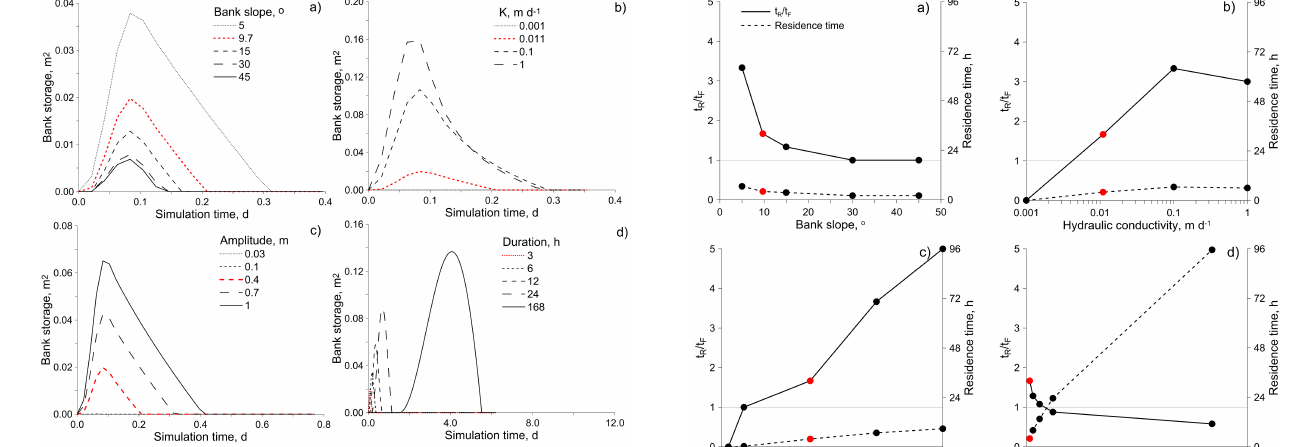
Figure 7. Bank storage for different bank slope (a) , hydraulic con- ductivity (b) , wave amplitude (c) and duration (d) scenarios, with the reference case (red) and insets of the input wave pulse. Note different scale.